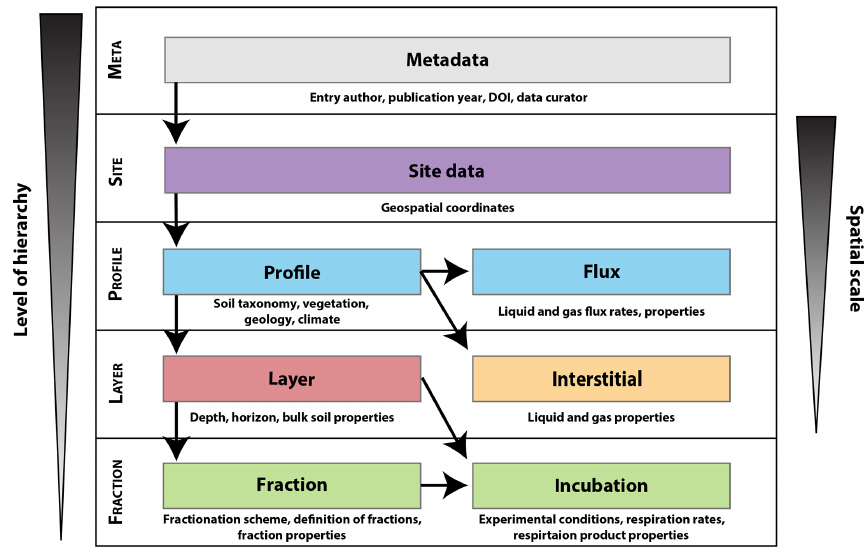
Figure 1. Conceptual diagram of an entry in the database. Each box represents a table in an entry; the horizontal bars distinguish the hierarchical levels of the database. Arrows show the hierarchical relationship between and among levels of the database. Time is considered at the profile level, as this is the coarsest spatial scale for which observational data are reported. Every time a profile is sampled, a unique profile identifier must be generated, consisting of the profile name combined with the profile observation date, which is then linked to all measurements made at or below the profile level of the